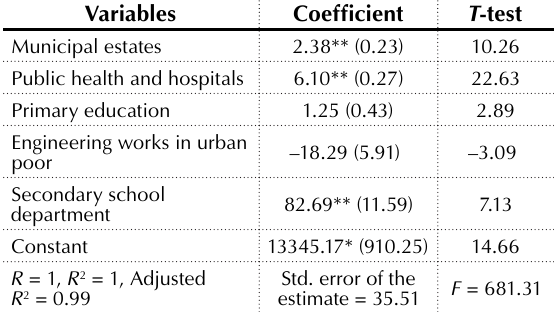
Table 7. Regression result for